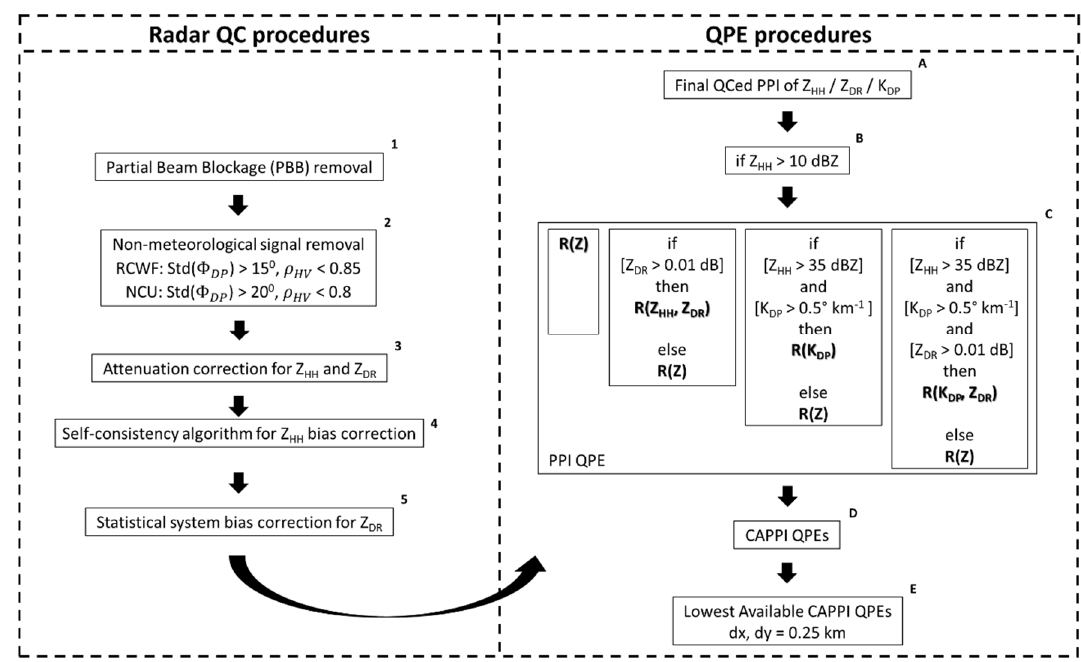
Figure 2. The flow chart of the quality control (QC) and QPE procedures.